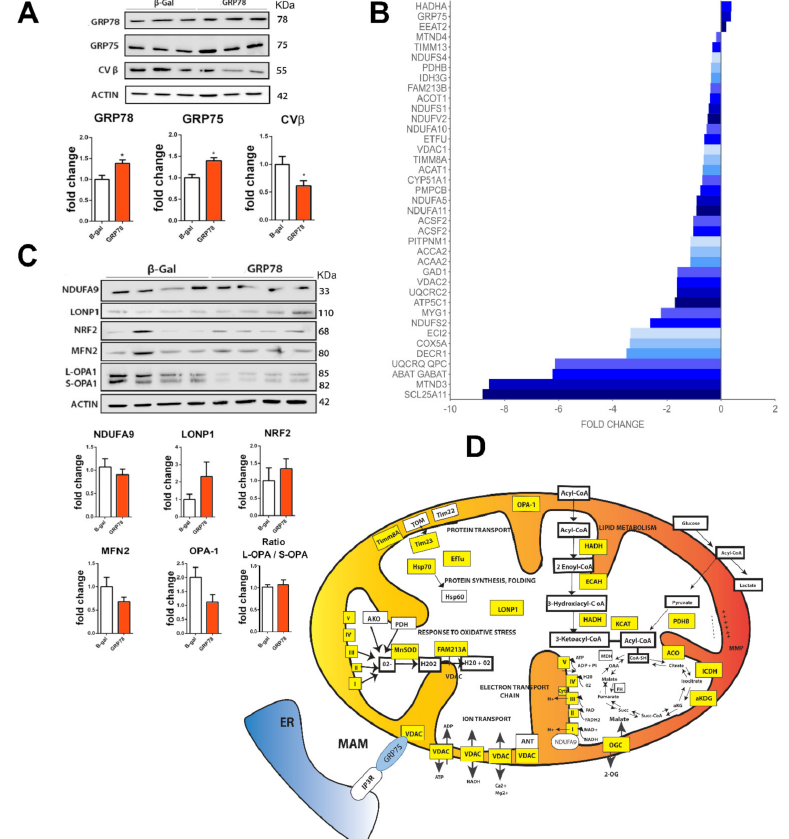
Figure 1. GRP78 overexpression in RA-injured animals targets mitochondrial proteins. ( A ) Immunoblot and bar graphs showing average fold changes ( ± SEM) of GRP78, GRP75, and CV β protein levels in L4-L5 spinal cord segments in GRP78 vs. β -Gal overexpressing RA-injured rats by 7 dpi. Levels were normalized to actin values ( n = 4; * p < 0.05 vs. Ad- β -Gal, Student’s t -test). ( B ) Histogram of mitochondrial protein fold changes obtained by proteomic analysis of L4-L5 spinal cord segments from in RA-injured animals that overexpress GRP78 compared to the Ad- β -Gal group by 7 dpi. ( C ) Immunoblot and bar graphs showing average fold changes ( ± SEM) of NDUFA9, LONP1, NRF2, MFN2, OPA-1 normalized to actin. (No significant differences between groups. Student’s t -test). ( D ) Schematic mitochondria with proteins altered by overexpression of GRP78 in L4-L5 spinal cord segments from RA-injured animals highlighted in yellow (decreased) or in blue (increased) at